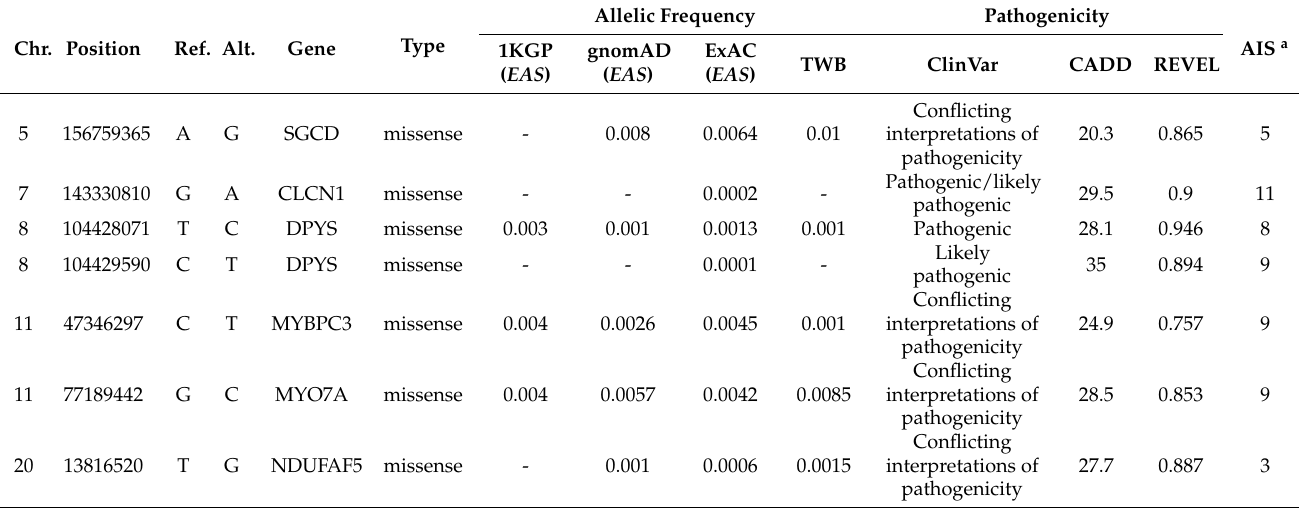
All coordinates are from human reference genome GRCh38. Chr.: chromosome. Ref.: reference allele. Alt.: alternative allele. a Patients who carry the variant, each patient carries one copy of the mutation